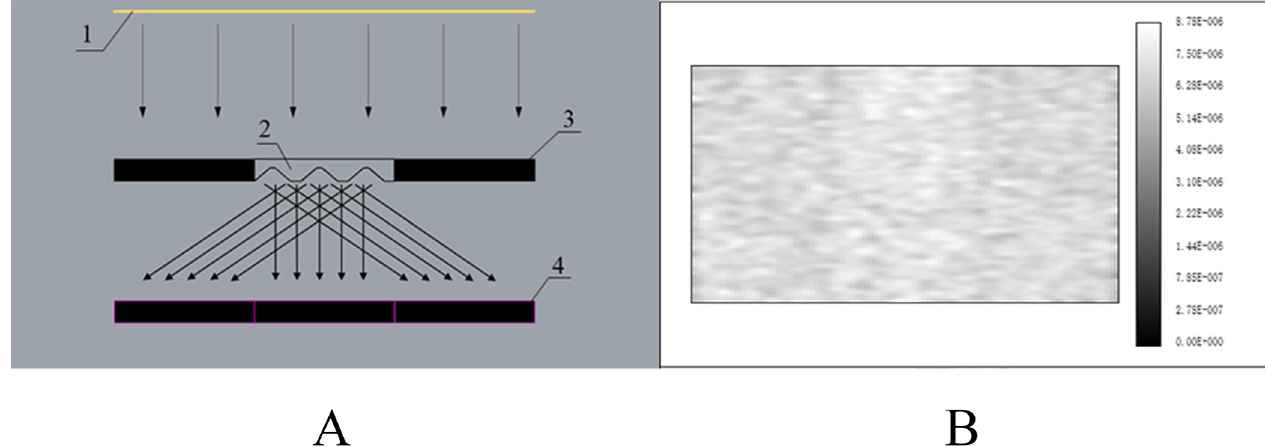
Fig 2. The light path of the optical simulation: 1 light source; 2 grooved glass plate; 3 PV panel; 4 illuminance detector (A). The illuminance simulation result of the glass plate (B).